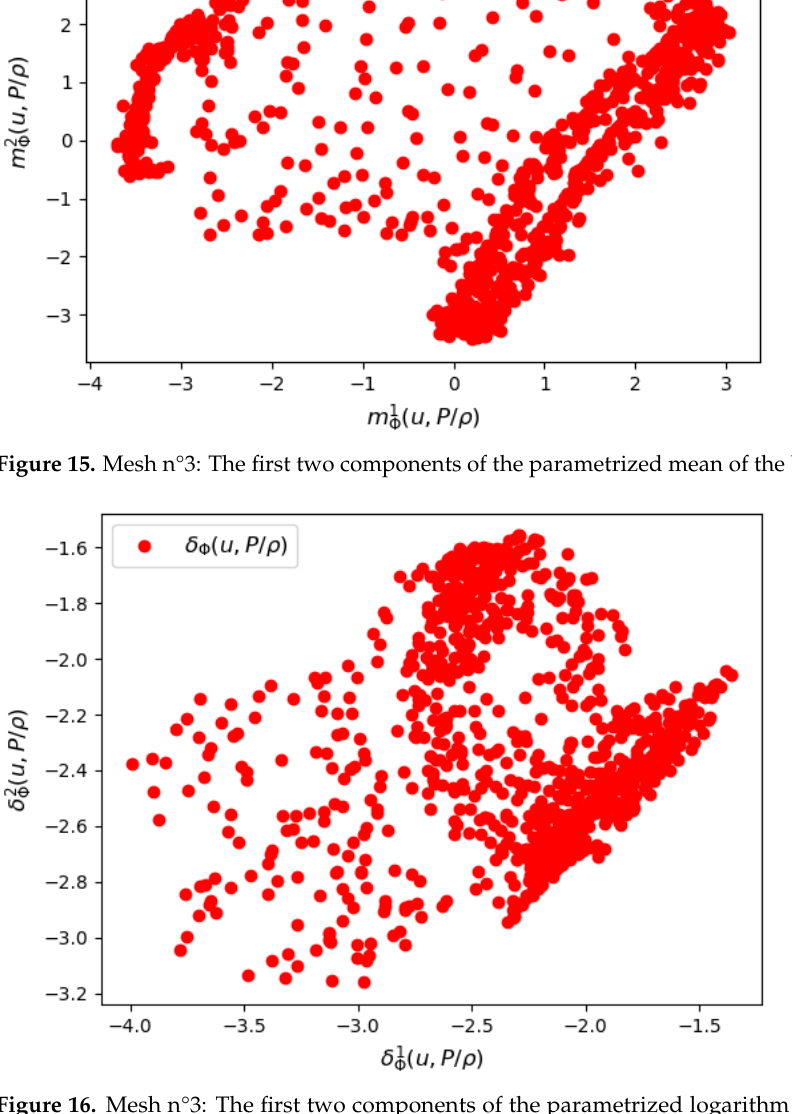
Figure 16. Mesh n°3: The first two components of the parametrized logarithm of variance by the VAE